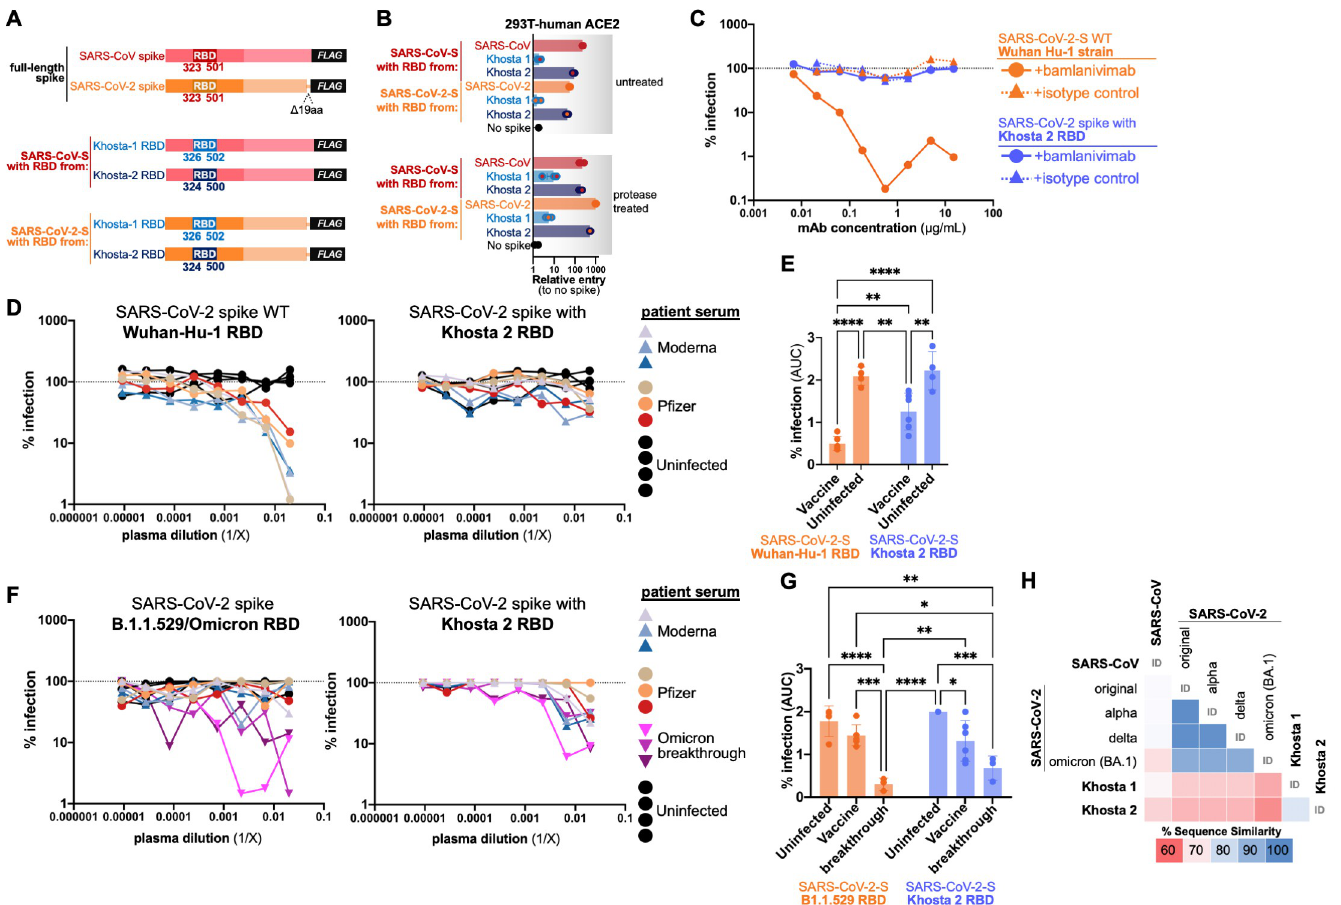
Fig 4. Chimeric SARS-CoV-2-Khosta 2 spike is resistant to current vaccines. ( A ) The RBD from SARS-Cov-2 spike was replaced with Khosta 2 RBD. ( B ) Pseudotpyes with indicated chimeric spikes were used to infect 293T cells stably expressing human ACE2. Pseudotypes were combined with ( C ) bamlanivimab or ( D ) vaccinated patient serum at various concentrations and used to infect 293T-hACE2 cells.( E ) Area under the curve analysis for data in panel D. p-value 0.0021 ( �� ), 0.0002 ( ��� ), < 0.0001 ( ���� ). ( F ) Pseudotypes with Khosta 2 or Omicron variant RBD were combined with serum from vaccinated patients with breakthrough Omicron infection and used to infect 293T-hACE2 cells. ( G ) Area under the curve analysis for data in panel F. p-value 0.0021 ( �� ), 0.0002 ( ��� ), < 0.0001 ( ���� ) ( H ) Sequence identity matrix for RBD amino acid sequences from Khosta 2 and known SARS-CoV-2 variants of concern.